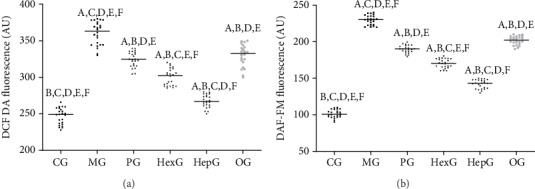
Oxidative stress analysis. (a) The levels of reactive oxygen species (ROS). (b) The levels of reactive nitrogen species (RNS). Ap < 0.05 vs. the CG group, Bp < 0.05 vs. the MG group, Cp < 0.05 vs. the PG group, Dp < 0.05 vs. the HexG group, Ep < 0.05 vs. the HepG group, and Fp < 0.05 vs. the OG group. n = 8 for each group.